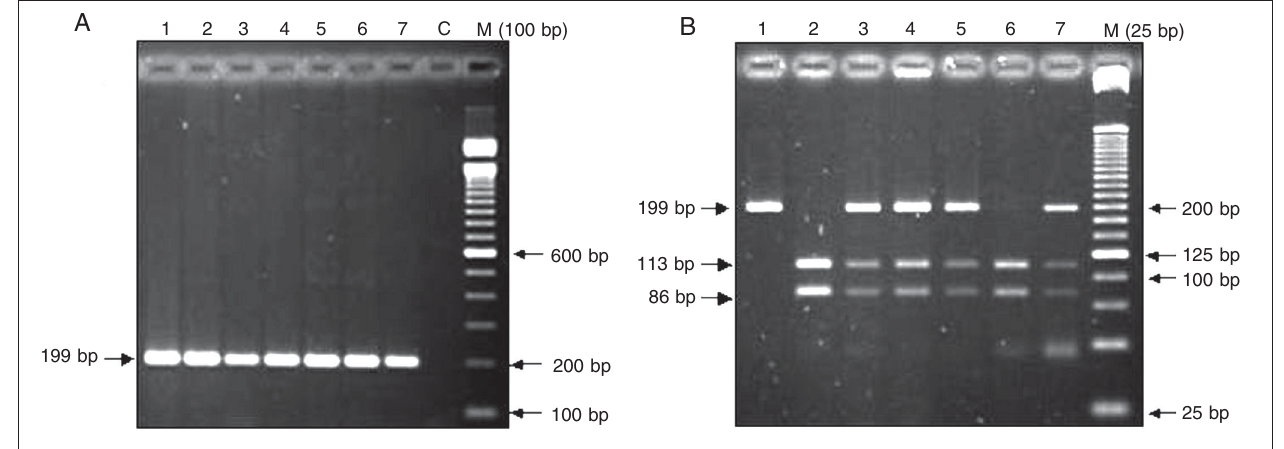
Figure 1. A , PCR product amplification of TP53 codon 72 gene. Lanes 1-7 : PCR products; C : negative control and M (100 bp): 100-bp DNA marker (Gibco, Gaithersberg, MD, USA). B , Restriction fragment length polymorphism on 4% GTG agarose gel. Lane 1 : P (Pro) allele (199 bp); lanes 2 and 6 : R (Arg) allele (113 + 86 bp), and lanes 3, 4, 5 , and 7 : PR genotype (199 + 113 + 86 bp). M (25 bp): 25-bp DNA